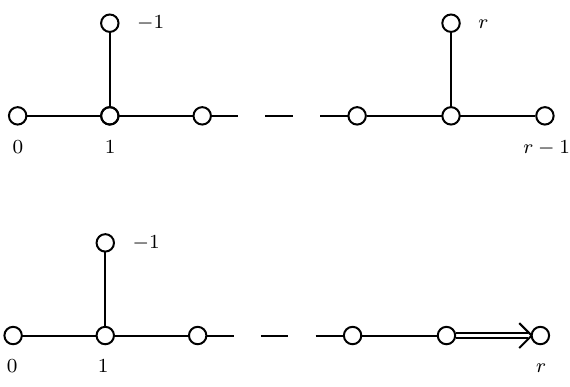
(lower) and D (1) (upper). These are relevant for the in(cid:12)nite r +1 r +1